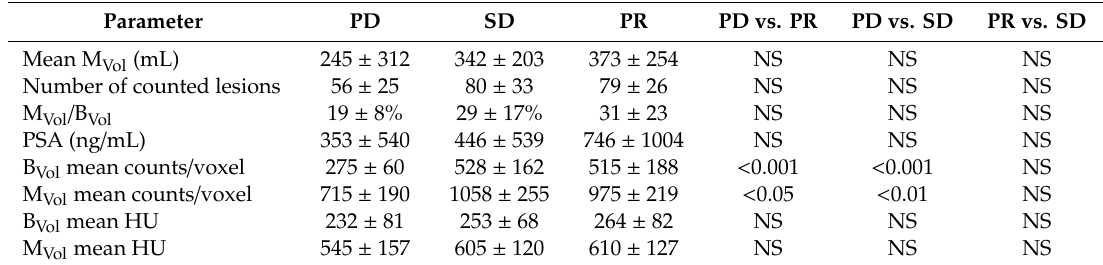
Table 2. Radiological and laboratory parameters according to